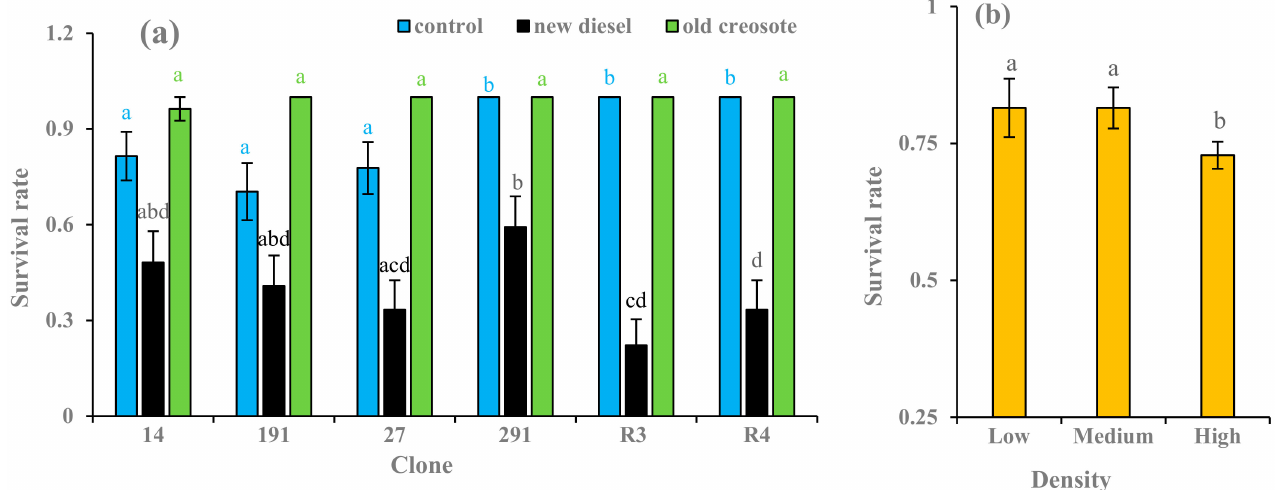
Figure 2. Average ( n =3) survival rates of European aspen and hybrid aspen clones grown in different soil treatments ( a ) and plant densities ( b ). Error bar indicates ± standard error (SE). Means between clones followed by the same lower-case letters with the same font color are not significantly different ( p > 0.05). Means between density treatments followed by the same lower-case letters are also not significantly different ( p >